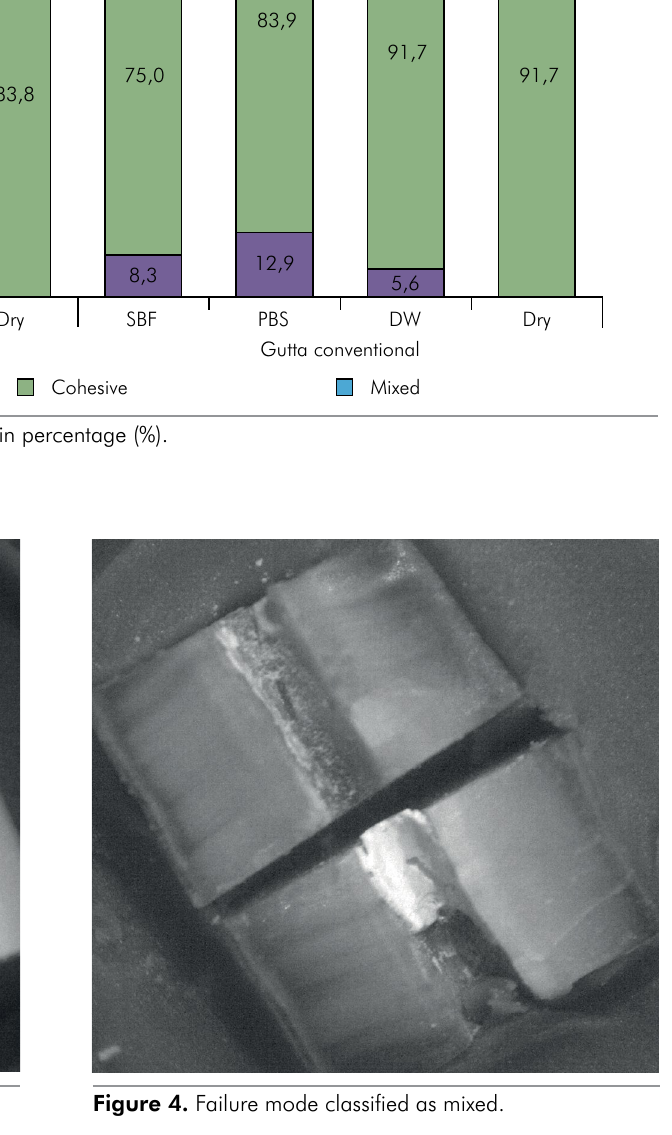
5 Braz. Oral Res.